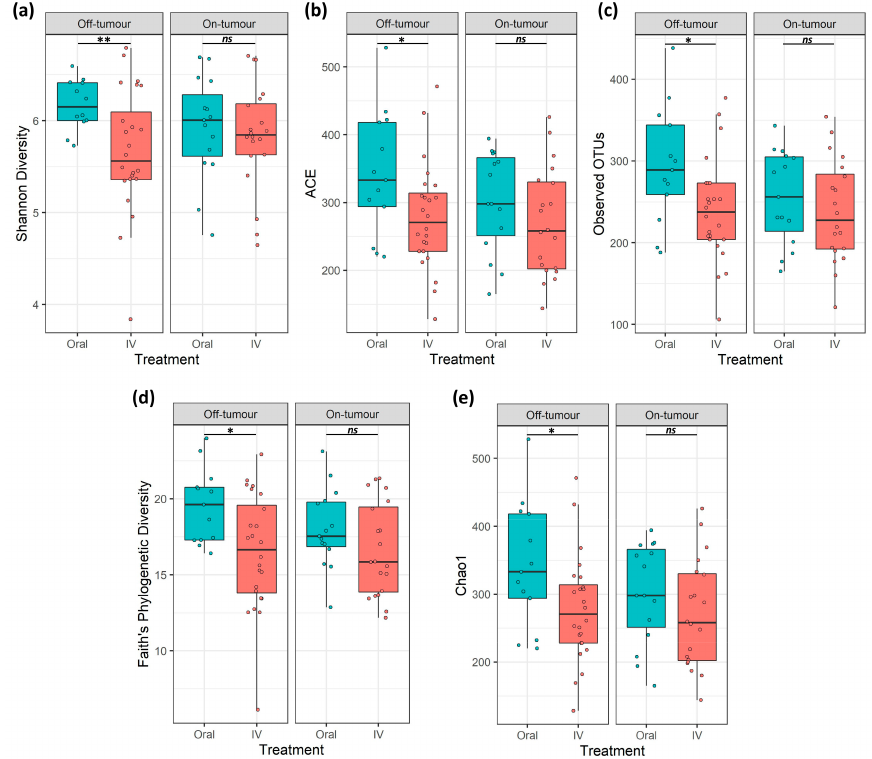
Figure 1. On- and off-tumor α -diversity is differentially altered following iron therapy. α -diversity metrics ( a ) Shannon diversity, ( b ) abundance-based coverage estimate (ACE), ( c ) observed operational taxonomic units (OTUs), ( d ) Faith’s phylogenetic diversity, and ( e ) Chao1. Off-tumor diversity metrics were significantly greater in oral iron compared to intravenous (IV) treated patients. On-tumor diversity showed no significant differences between oral and IV iron-treated patients (* p ≤ 0.05, ** p ≤ 0.01, ns p >